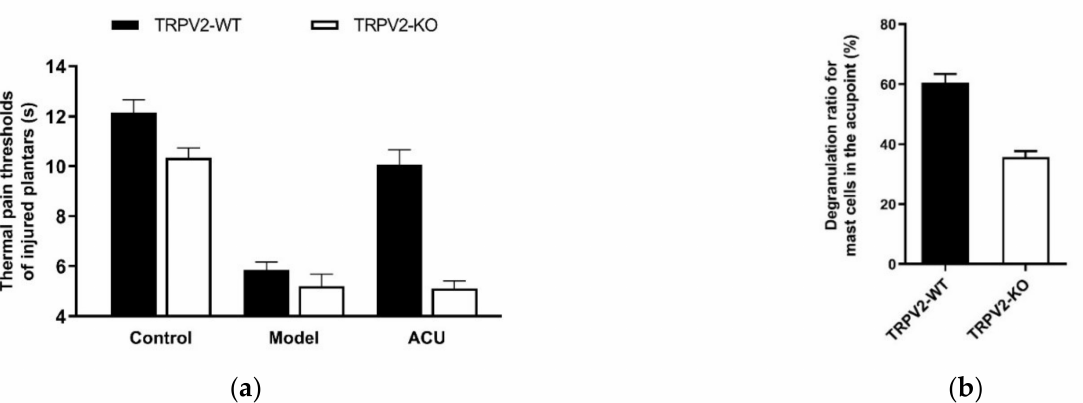
Figure 8. Effects of TRPV2 knock-out on acupuncture analgesia ( a ) and local MC degranulation ( b ) in ankle AA mice. Establishing the inflammation pain and acupuncture intervention was referred to in the legend of Figure 5. In ( a ), data show pain thresholds of injured plantars in response to heat (thermal hyperalgesia) stimulation. In ( b ), data are obtained from the paraffin sections are prepared from ST36 of wild-type (TRPV2-WT) and TRPV2 deficient (TRPV2-KO) mice. MCs were labeled with toluidine blue and were manually counted under microscope. Data represent means + SEM ( n = 10–11). Figure is from Huang et al. (2018) [32] with kind permission from Springer